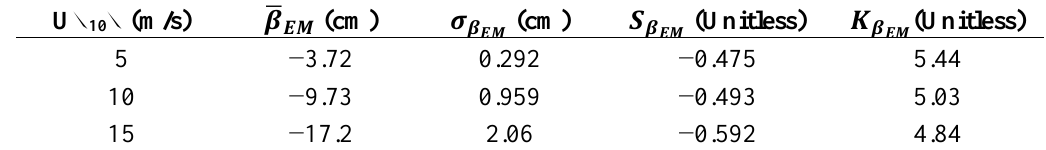
Table 2. EM bias time series main statistical descriptors for incidence/scattering θ = θ = 25°, wind direction φ = 45°, and U i s R R R R